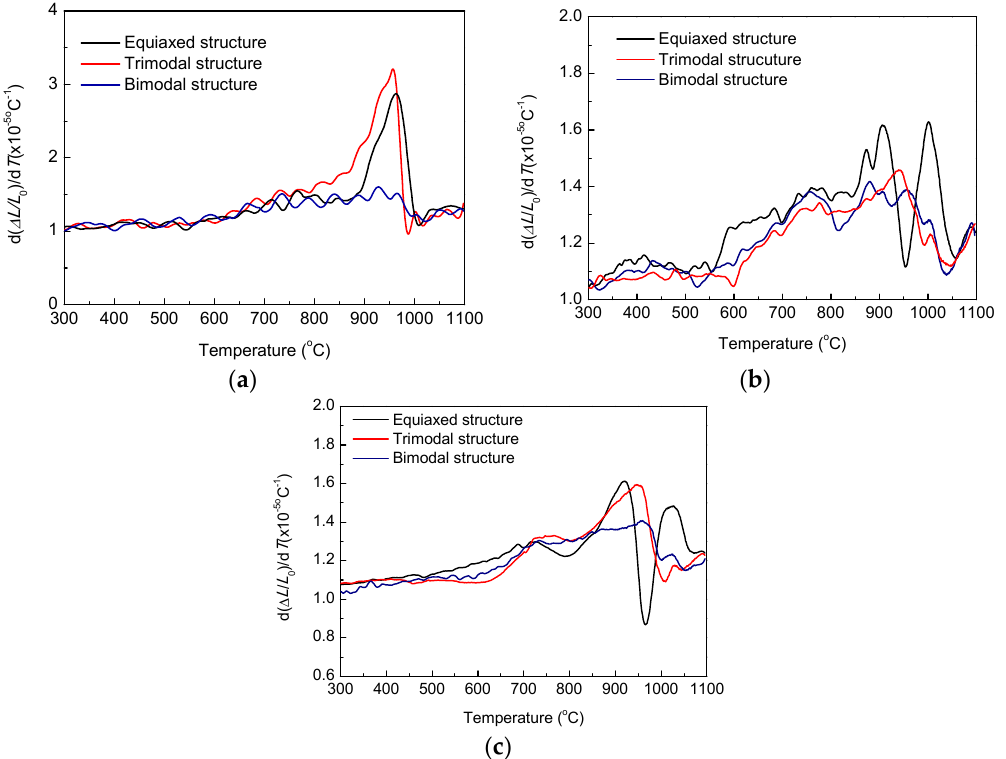
Figure 8. Derivatives of length change with respect to temperature (d L /d T ) of the different initially structures at the heating rate of ( a ) 5 °C/min; ( b ) 10 °C/min; ( c ) 20 °C/min. The phase transformation sequence in continuous heating is summaried in Table 2.